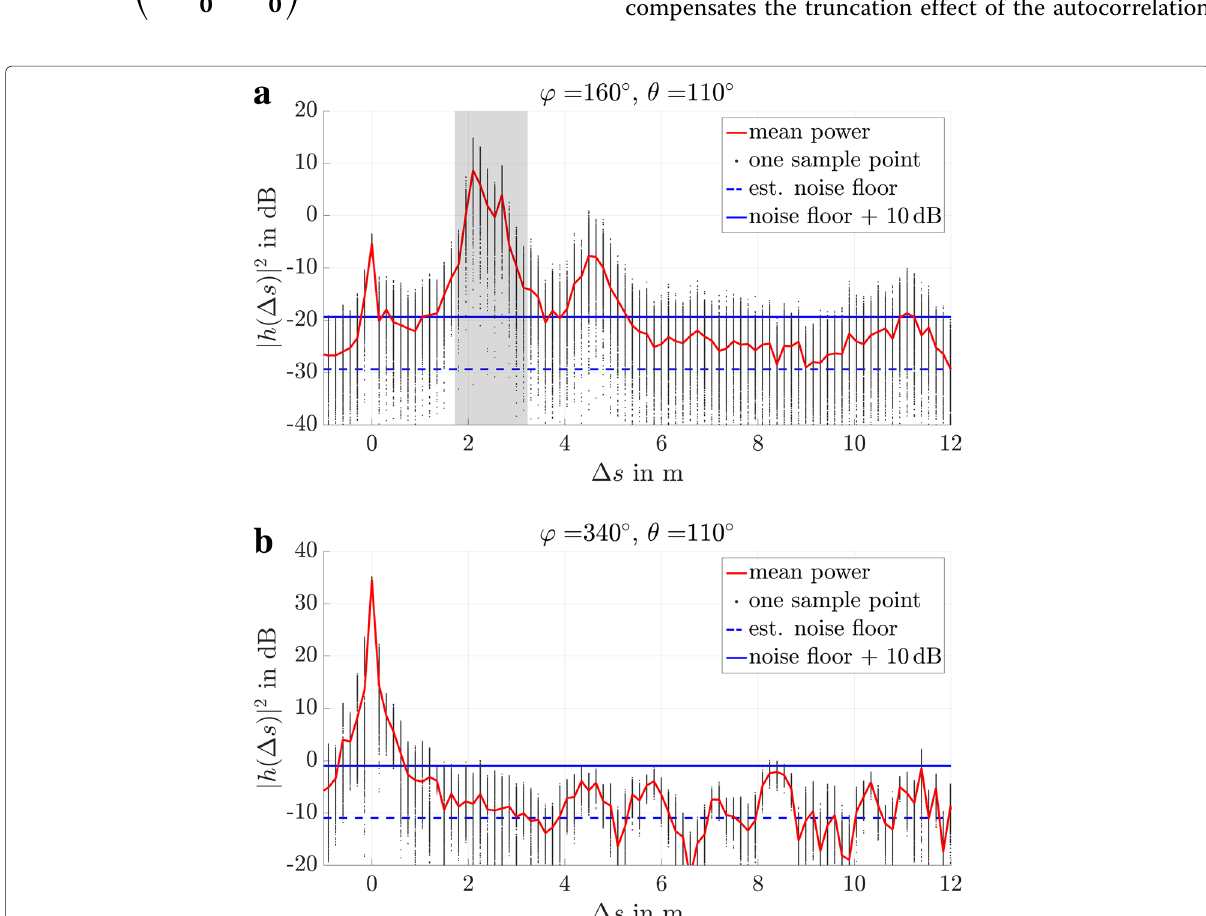
Fig. 14 Scatter-plot of the CIRs. We plot the CIRs as a function of spatial distance, where (cid:7) s = 0 corresponds to the LOS distance. Our spatial resolution (a channel tap) is 15cm. The spatial extend of our sampled cube (729 samples) is 2.8 λ = 1.4cm, a magnitude smaller than the spatial resolution. The scatter-plot is evaluated at a ( a ) wall reflection ( ϕ = 160 ◦ ) and at ( b ) LOS ( ϕ = 340 ◦ ). The mean power is plotted with a continous red line. We observe that the arrival cluster centred at 2.5m fades very deeply. The gray highlighted region around 2.5m is further analysed in Fig.